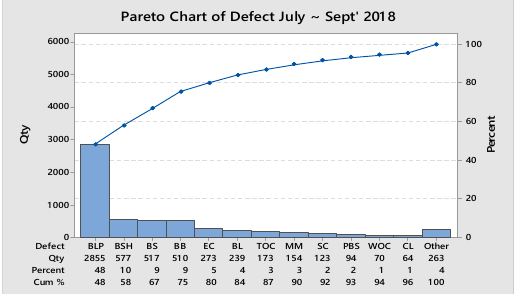
Fig. 3. Types of building process defective products Fig. 4. BLP based on machines type